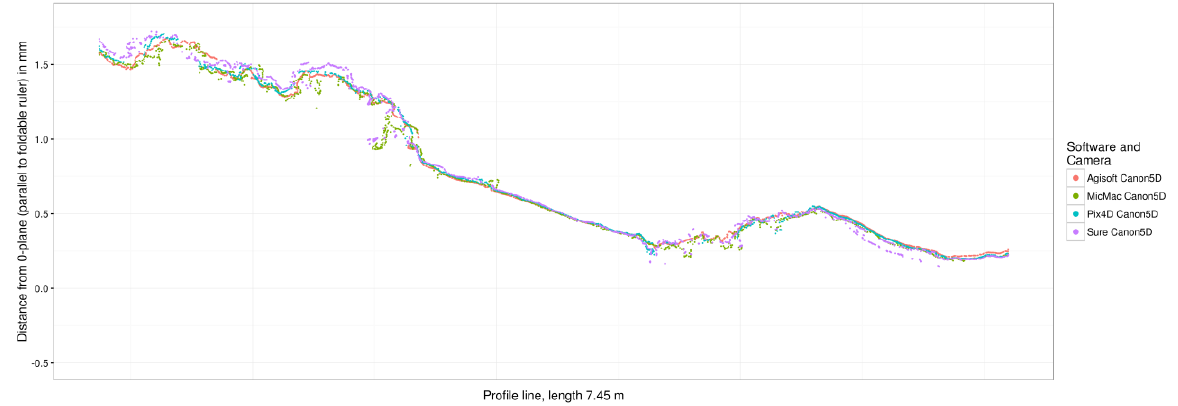
Figure 25. Profile lines of the point clouds generated by the different softwares using only the Canon5D images as input.